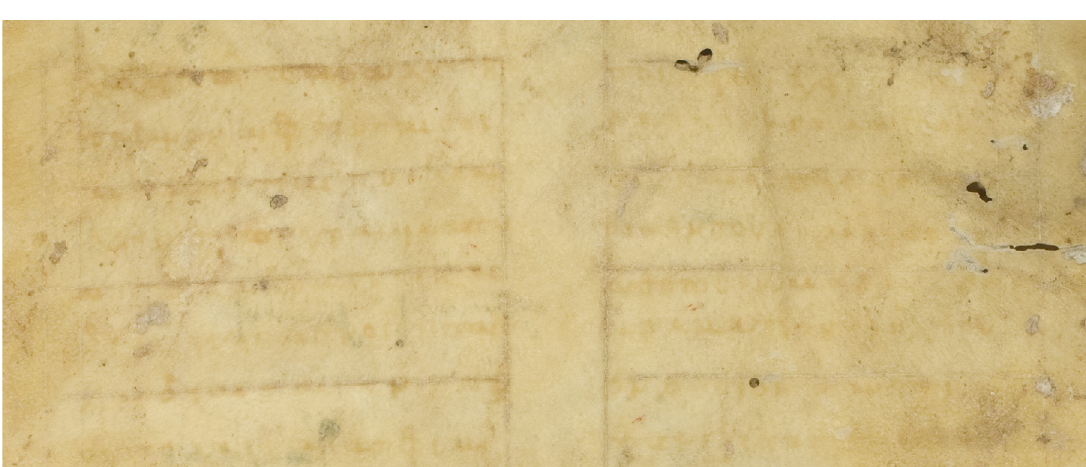
Figure 1. Detail of O.9.27, flyleaf 3, verso. Used with permission from the Master and Fellows of Trinity College